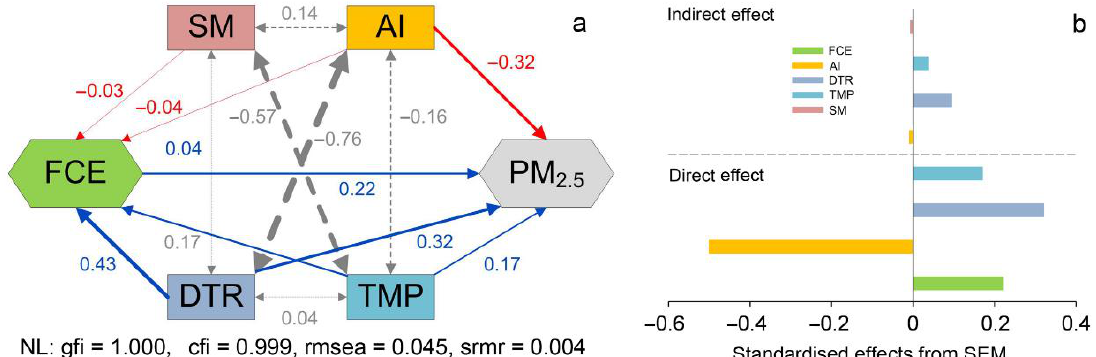
Figure 7. The impacts of meteorological factors on PM 2.5 exposure and FCE in NL as estimated using structural equation modeling ( a ). Blue and red lines indicate the paths of positive and negative relationships, respectively. The width of the lines represents the strength of standardized path coefficients. Gray dotted lines denote the covariance of exogenous variables. Single-head arrows present the hypothesized direction of causation. The number beside the dotted line is the standardized path coefficient. ( b ) Direct and indirect influence of climate and FCE on PM 2.5 exposure. The x -axis represents the standardized effects from SEM. Among them, the direct effect value was directly obtained from Figure 7a, and the indirect effect was obtained by multiplying two direct effects.